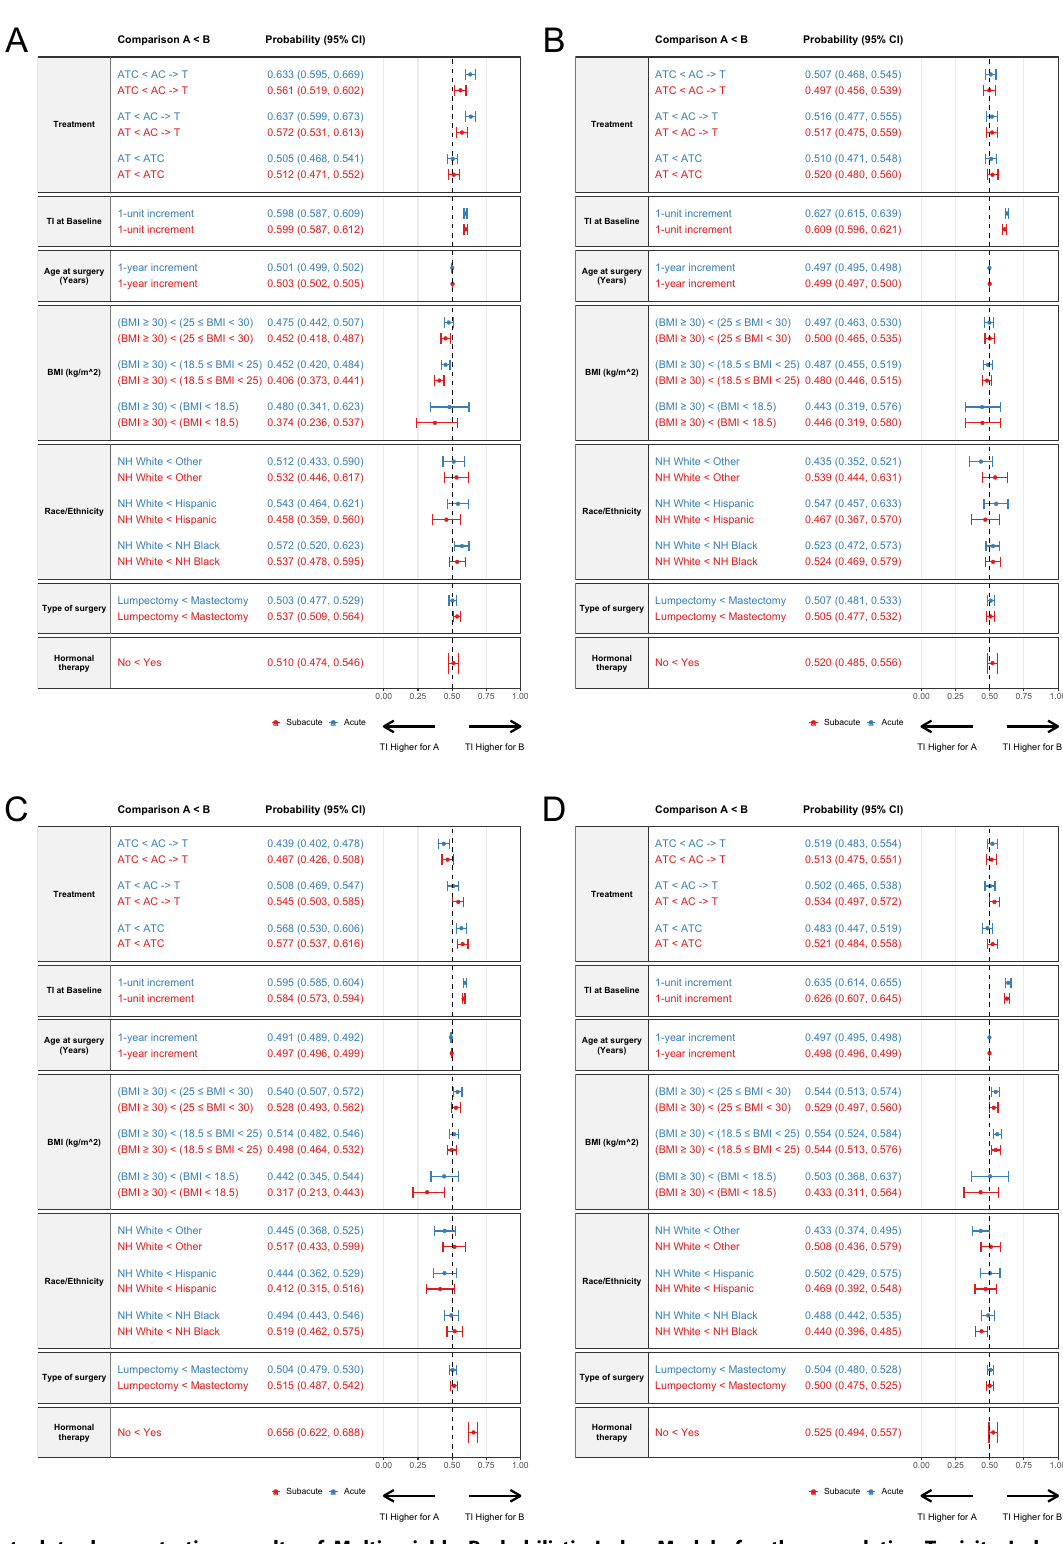
Fig. 3 Forest plots demonstrating results of Multivariable Probabilistic Index Models for the cumulative Toxicity Index (TI) for the symptom domains during the acute and subacute time periods. Comparison A < B denotes the probability that the cumulative TI for B is higher than that for A. When the probability is >0.5, B is more likely to be associated with the symptom domain, whereas when the probability is <0.5, A is more likely to be associated with the symptom domain. A pain domain. Acute (blue, N = 2075 patients) and subacute (red, N = 1791) time periods. B cognition domain. Acute (blue, N = 2078 patients) and subacute (red, N = 1793) time periods. C vasomotor domain. Acute (blue, N = 2075 patients) and subacute (red, N = 1791) time periods. D vaginal domain. Acute (blue, N = 2068 patients) and